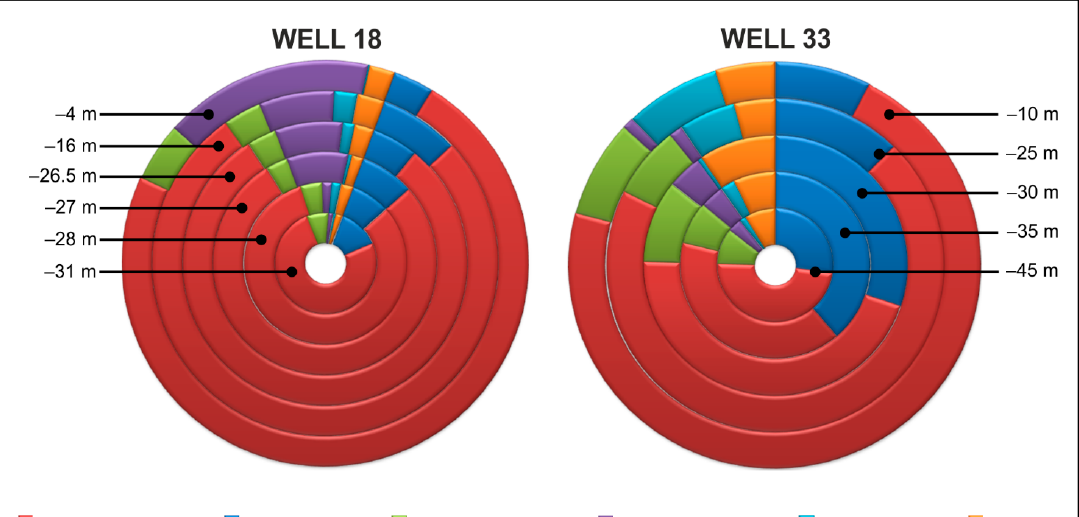
Figure 7. Five major phyla and differences among microbial communities in waters collected at different depths from wells 18 and 33. The remaining taxa are labelled as